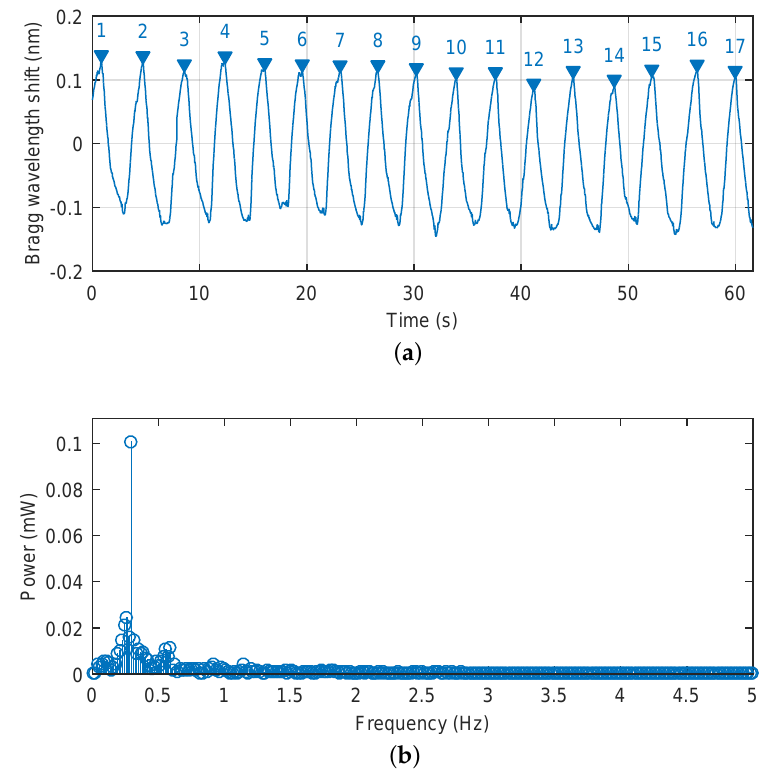
Figure 8. The Bragg wavelength shift ( a ) and frequency spectrum ( b ) during monitoring of the subject’s M1’s breathing activity.